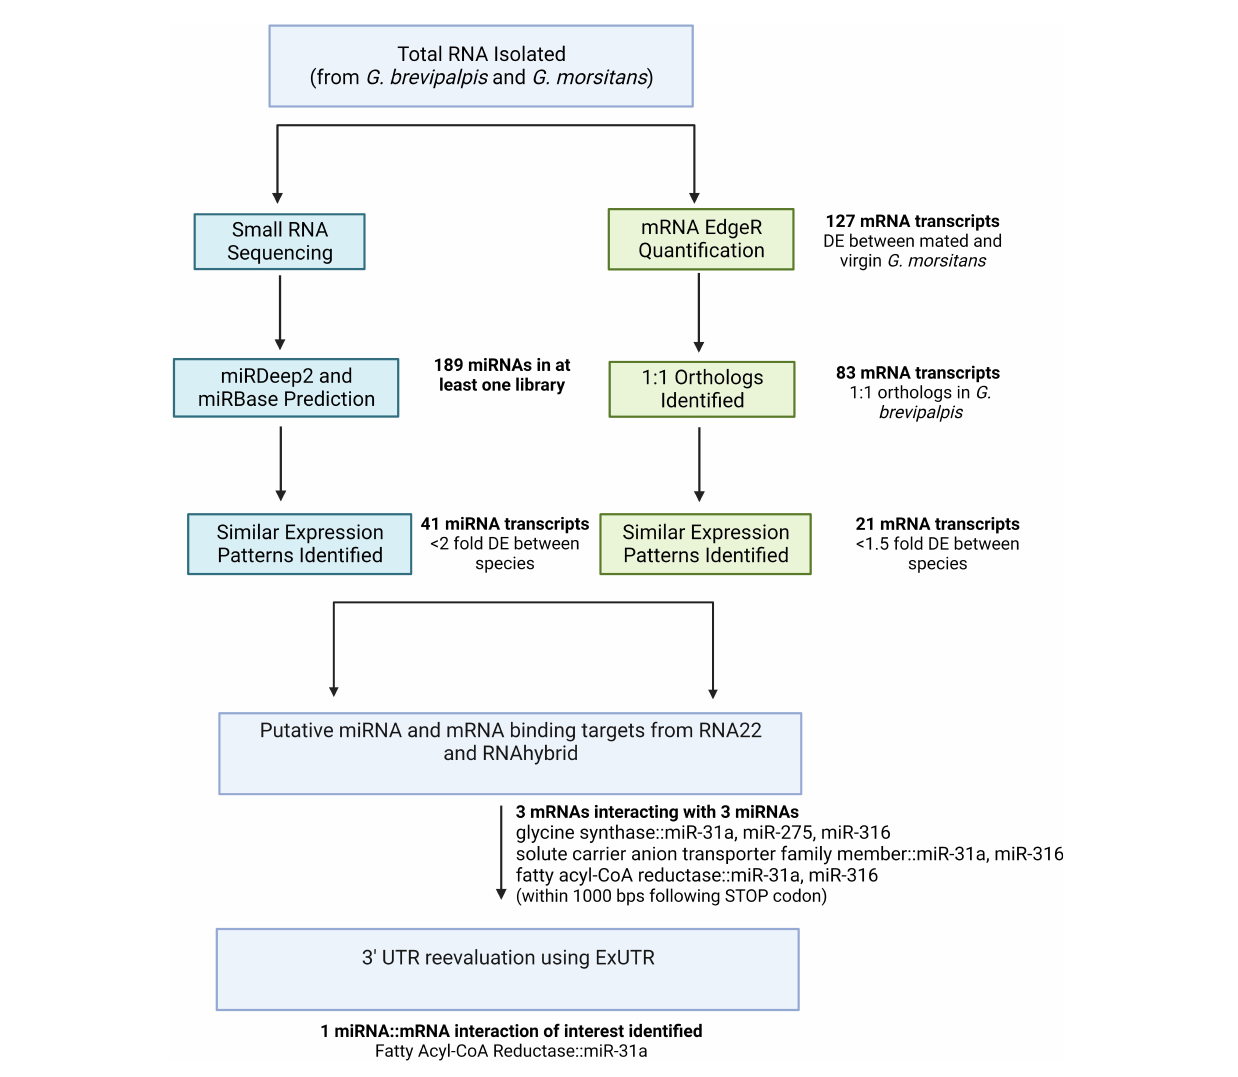
FIGURE1 A simplified flowchart of the bioinformatic pipeline used to generate miRNA and mRNAs of interest. Three genes with multiple mRNA::miRNA interactions were predicted, with only miR-31a::fatty acyl CoA-reductase remaining following final evaluation with ExUTR. DE, differentially